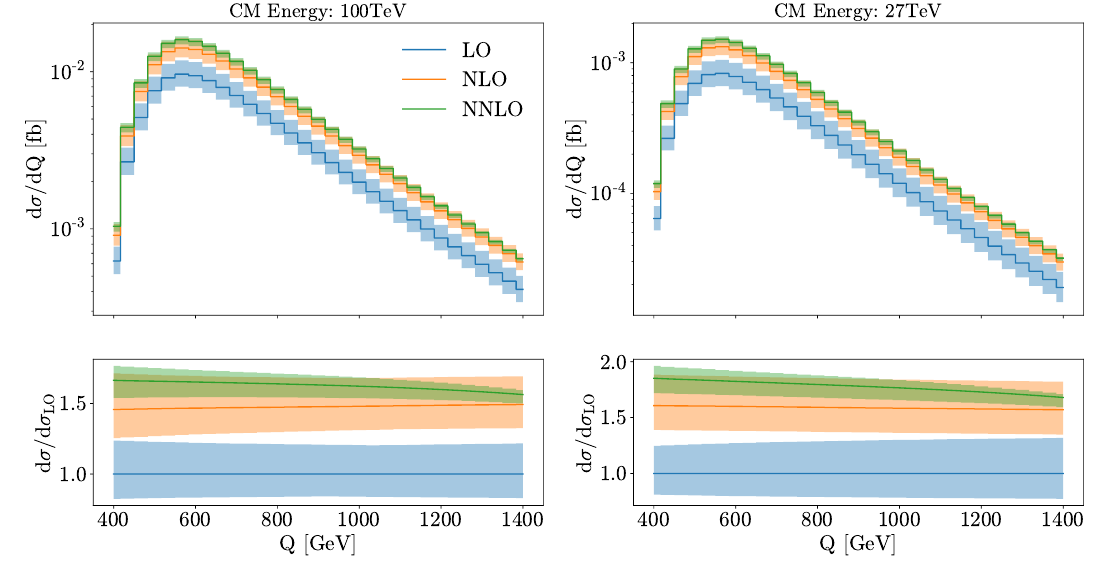
Figure 6 . Invariant mass distribution of the triple Higgs system in the dBi approximation up to di(cid:11)erent orders (up) and corresponding K factor (down). The results are shown for a collider center of mass energy of 100 TeV (left) and 27 TeV (right). The shaded bands correspond to the uncertainty from the variation of scales from the central value of (cid:22) 0 = Q= 2.